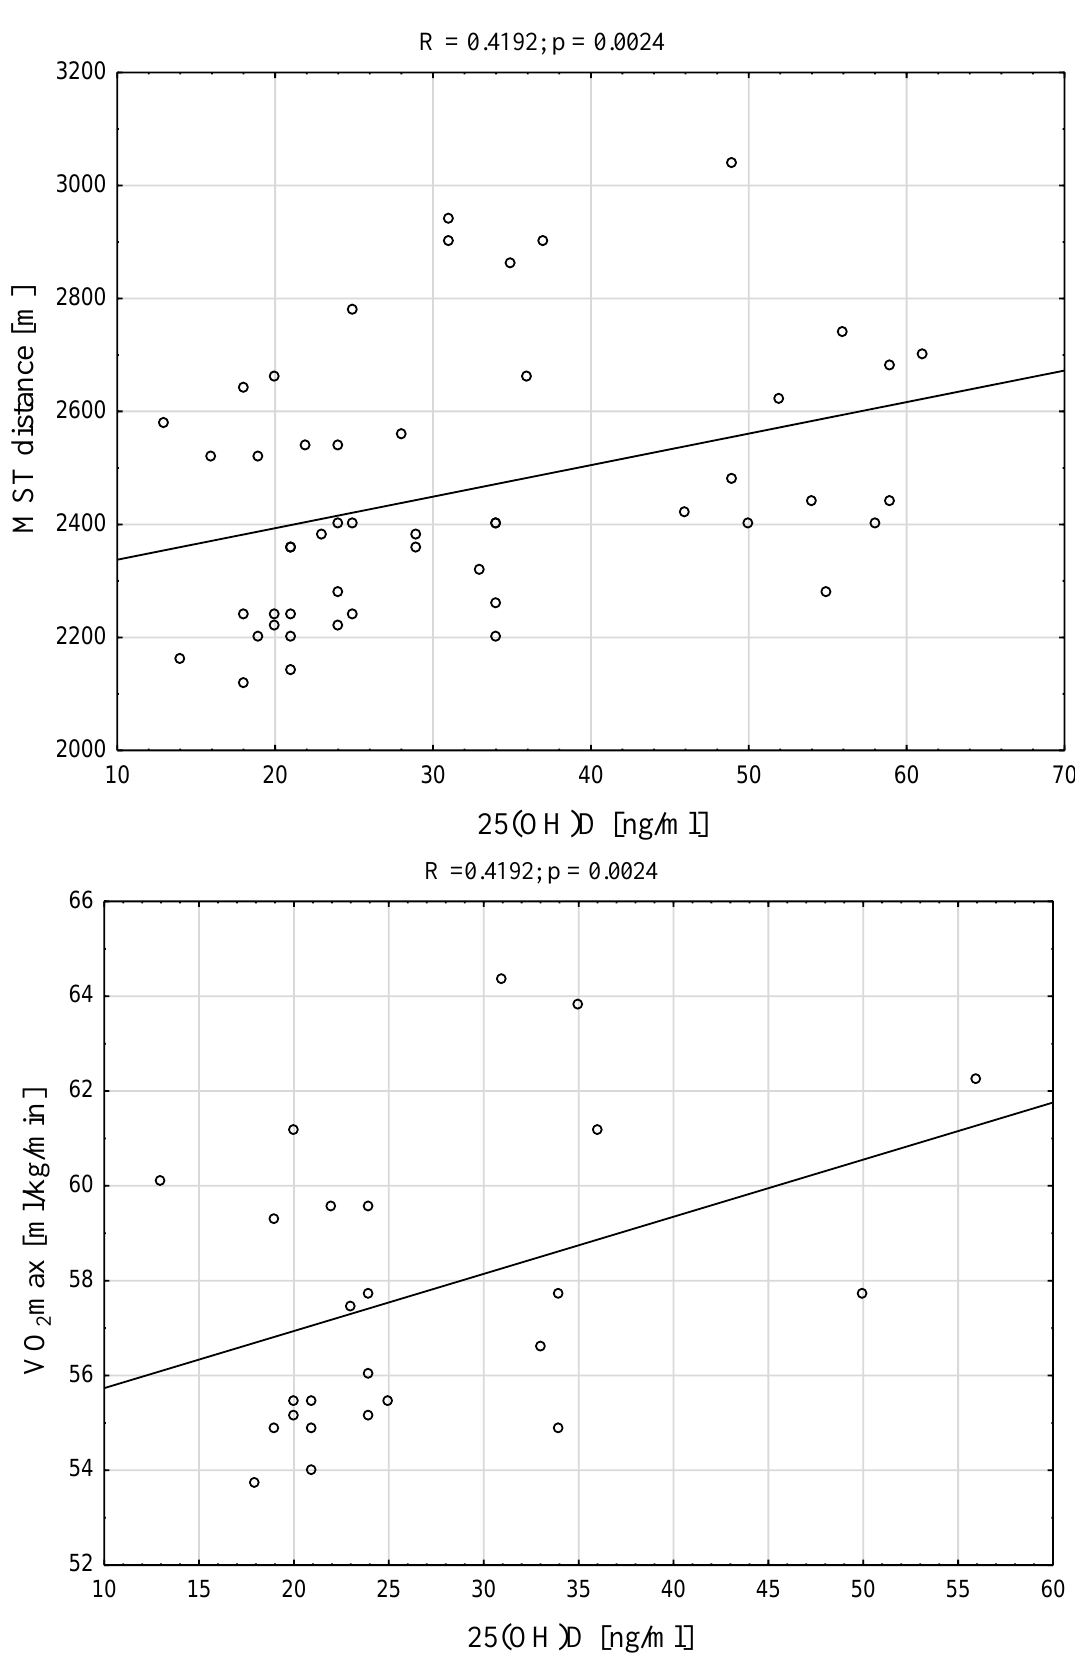
Figure 2. Correlation between of 25(OH)D concentration and MST distance and 25(OH)D and VO2max in young soccer players.